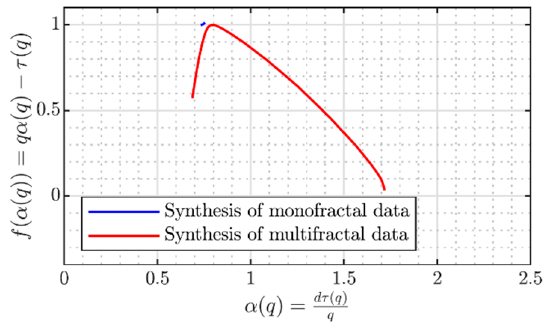
Figure 15. MS of the traces analyzed.